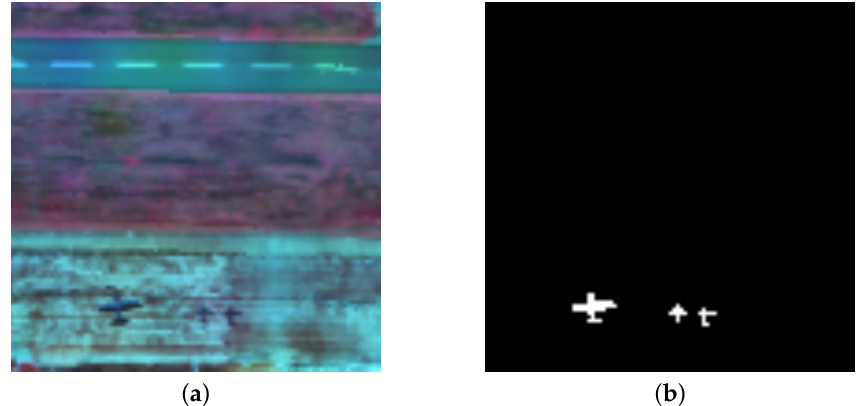
Figure 4. Illustration of the Gulfport dataset: ( a ) false color (RGB: 60, 30, 20); ( b ) the ground-truth map.